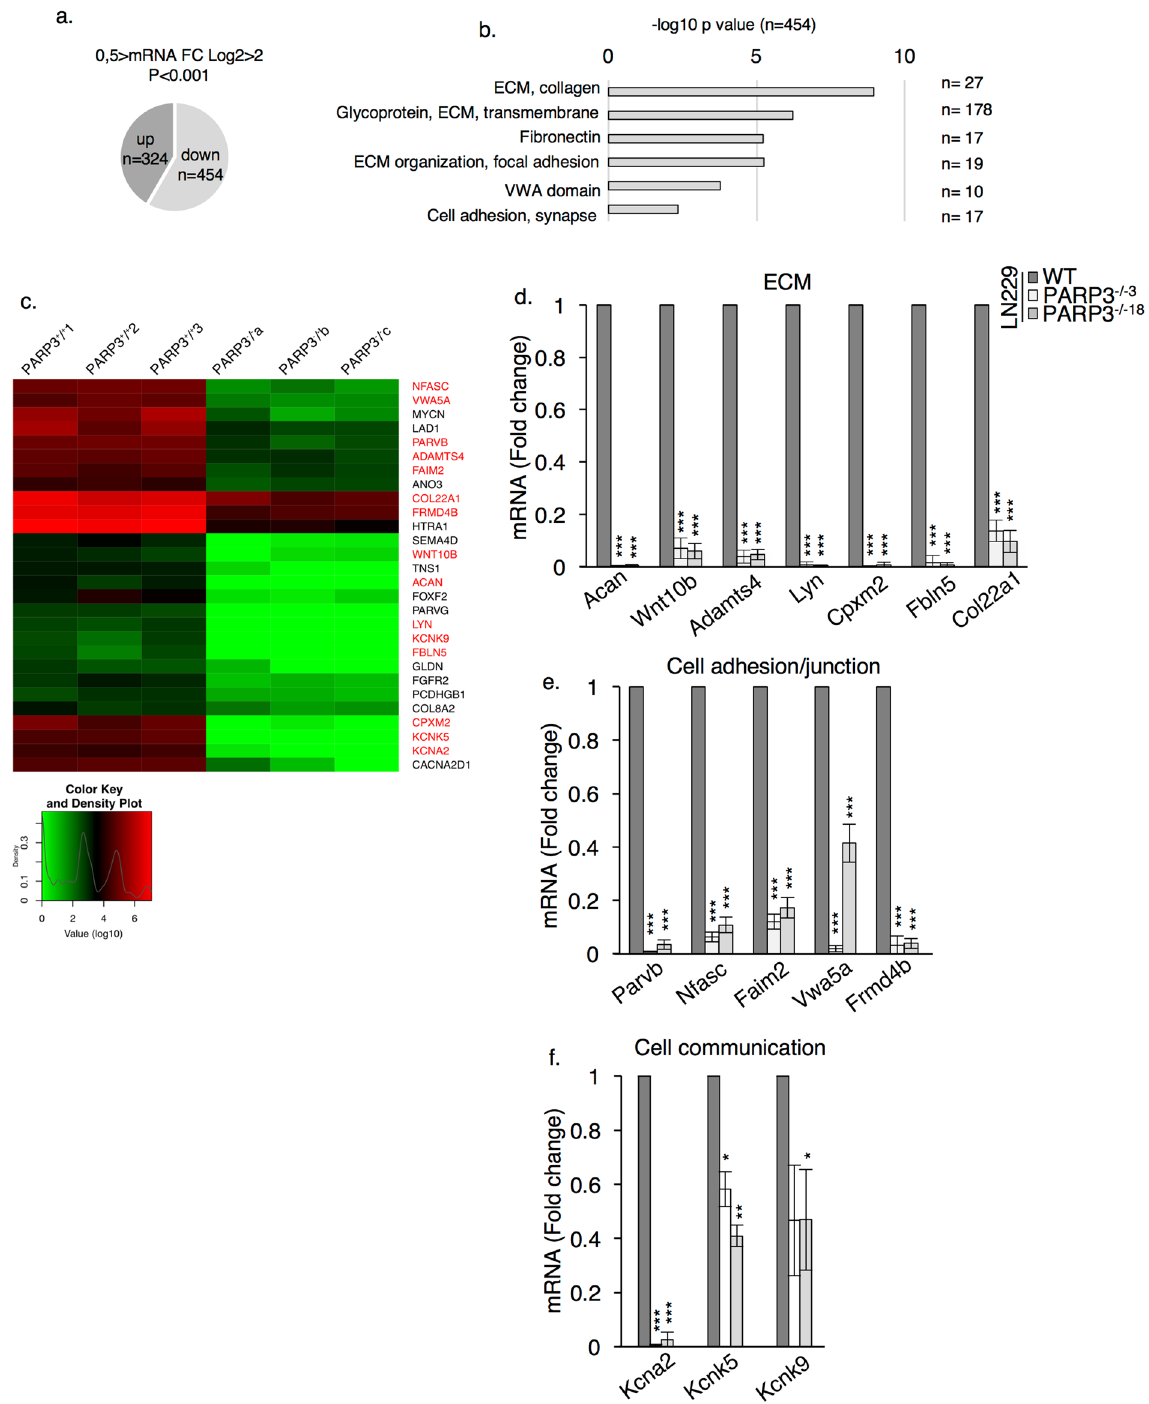
Figure 3. RNA seq reveals downregulation of transcripts coding for proteins involved in the organization of the ECM, in cell adhesion/junction, cell migration and communication. ( a ) Venn diagram illustrating the number of deregulated transcripts in PARP3 −/− LN229 cells (454 downregulated genes and 324 upregulated genes). ( b ) Pathway overrepresentation analysis of the 454 downregulated transcripts deduced with the DAVID bioinformatics resources 6.8. Number in brackets indicate the number of genes enriched, clustering to the corresponding pathway. ( c ) Clustered heatmap of downregulated transcripts in the ECM, cell adhesion and communication pathways. PARP3 +/+1 , PARP3 +/+2 , PARP3 +/+3 represent three biological replicates of WT RNA extracts while PARP3 −/−a , PARP3 −/−b , PARP3 −/−c represent three biological replicates of PARP3-deficient RNA extracts. Transcripts highlighted in red were used for subsequent validation experiments. ( d–f ) qPCR validation of the selected downregulated transcripts from the ECM ( d ), cell adhesion/junction ( e ) and cell communication ( f ) pathways in WT and PARP3 −/−3 and PARP3 −/−18 LN229 cell lines. Data are expressed relative to Gapdh . Values represent means ± s.e.m. of three independent experiments and